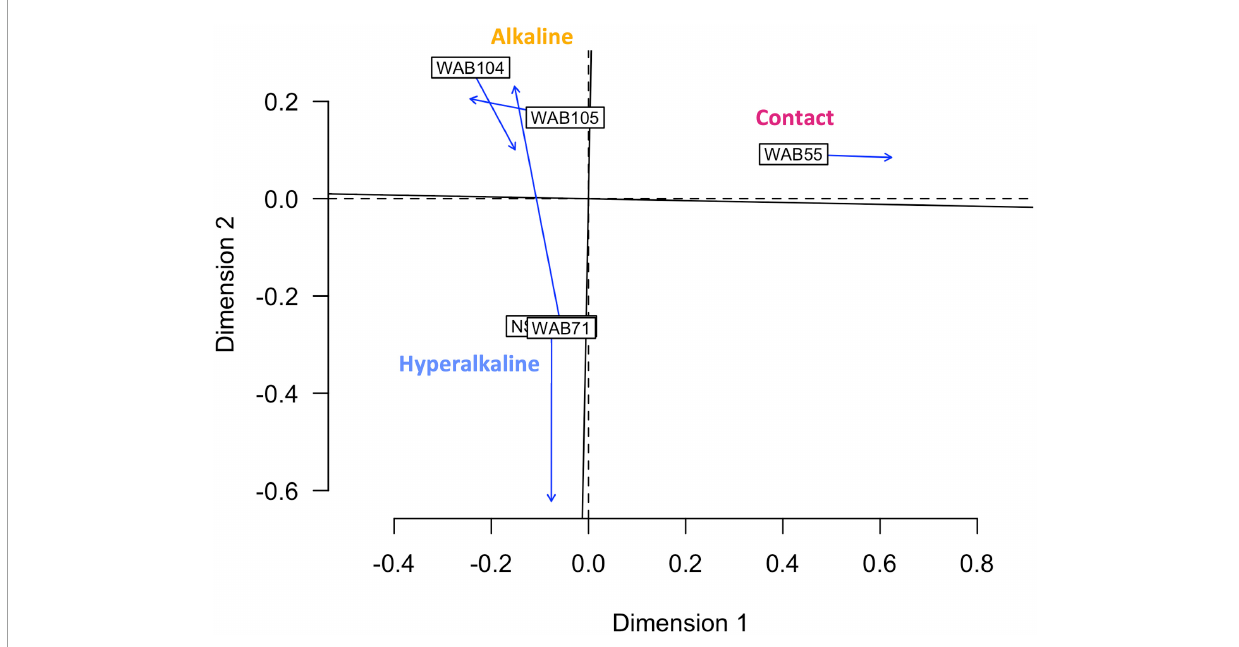
FIGURE4 Procrustes analysis in which the metabolomic feature abundance and bin abundance ordinations are optimally superimposed through rotating and rescaling, showing that metabolomic feature abundance and bin abundance are correlated. Hyperalkaline wells and alkaline wells cluster together, while the contact well is distinct from both. Labeled boxes indicate the position of the samples in the first ordination, and arrows point to their positions in the target ordination. The dashed lines represent the axes of the first ordination (bin abundance); the solid lines represent the axes of the target ordination (metabolomic feature